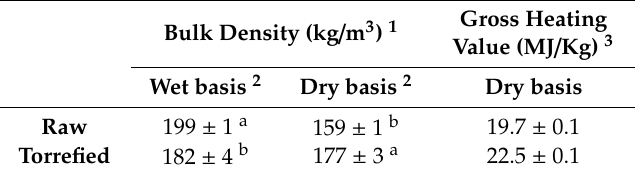
Table 2. Bulk density and calorific value of raw wood chips and torrefied wood used in this study.